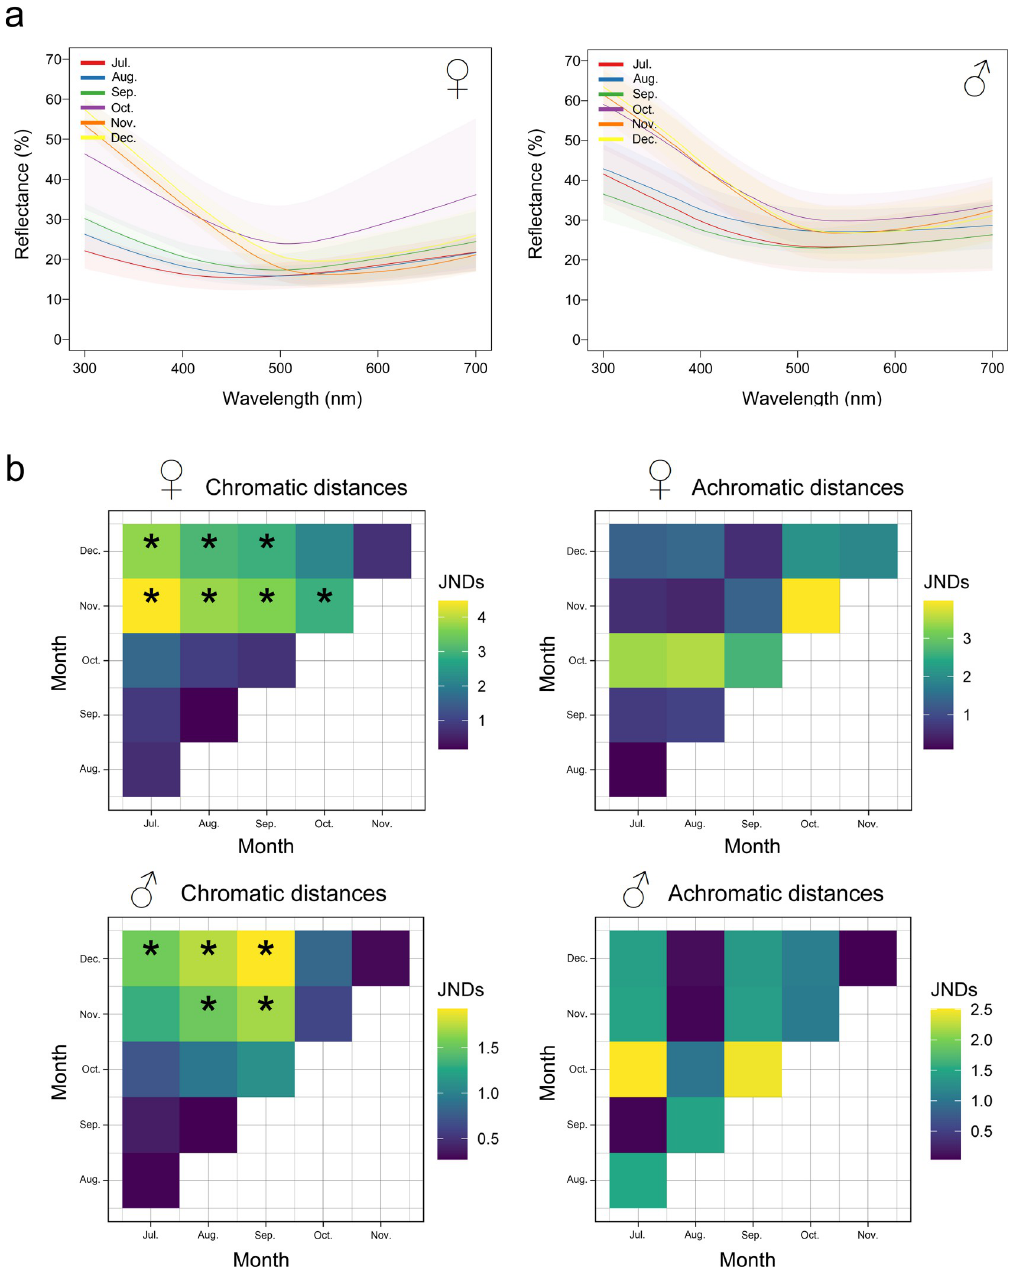
Fig 2. Seasonal change in crown coloration. a) Reflectance spectra of the crown of male and female Eared Doves over 6 months (winter and spring-summer) in the range visible to birds (300 to 700 nm). Data are shown as mean ± 2 SE. b) Chromatic and achromatic distances in JNDs obtained after applying an avian visual model for both sexes. Significant differences ( α = 0.05; indicated by � ) are only observed in the pairwise chromatic distances between winter and spring in both sexes. Month pairs were considered significantly different when the lower bond of the 95% confidence interval for the geometric mean of their distances was higher than 1 JND. Confidence intervals were obtained after 10000